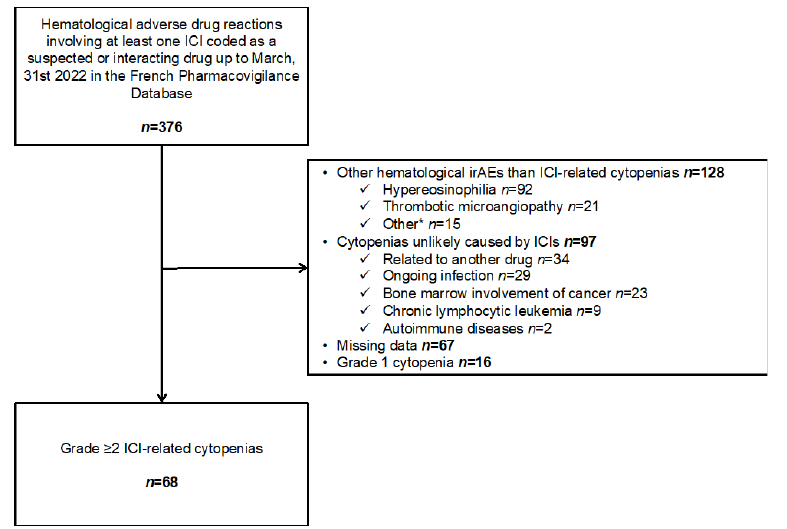
Figure 1. Flow chart. * Lymphopenia ( n = 8), bleeding event without cytopenia ( n = 4), hemophagocytic lymphohistiocytosis ( n = 1), lymph node enlargement ( n = 1), no cytopenia after experts’ review ( n = 1). ICI: Immune checkpoint inhibitor, irAEs: Immune-related adverse Table 1. Characteristics of the study population.